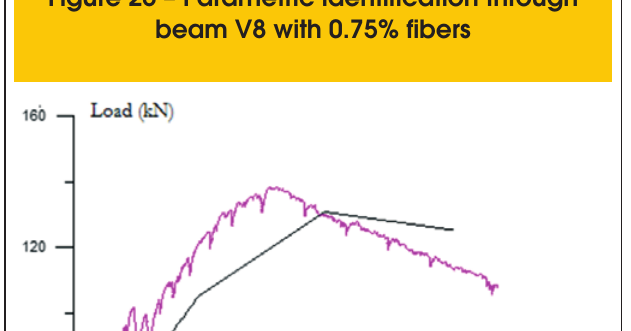
Figure 26 – Parametric identification through beam V8 with 0.75% fibers